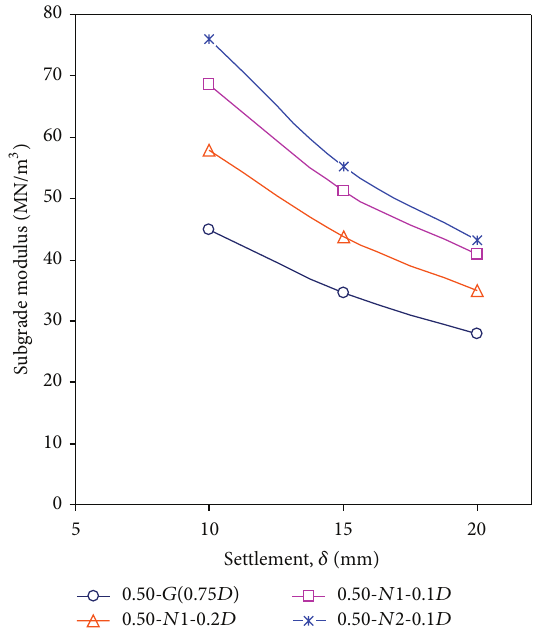
Figure 18: Subgrade modulus for Series III ( 𝐷 = 0.50 𝑀 ), compari- son.